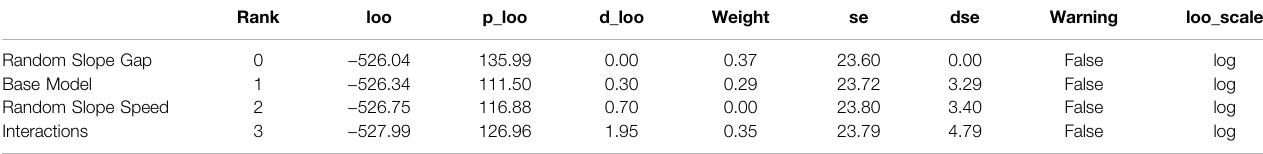
TABLE 1 | Model comparison for predicting crossings as a function of condition, gap size, and speed as fi xed factors and participant as a random factor. In addition to this base model, the other models include either a random slope for gap or speed, while one model features two-way interactions of gap and speed with